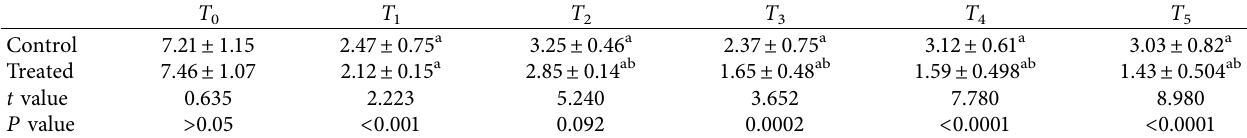
Table 2: Comparison of VAS scores between two groups of patients at different